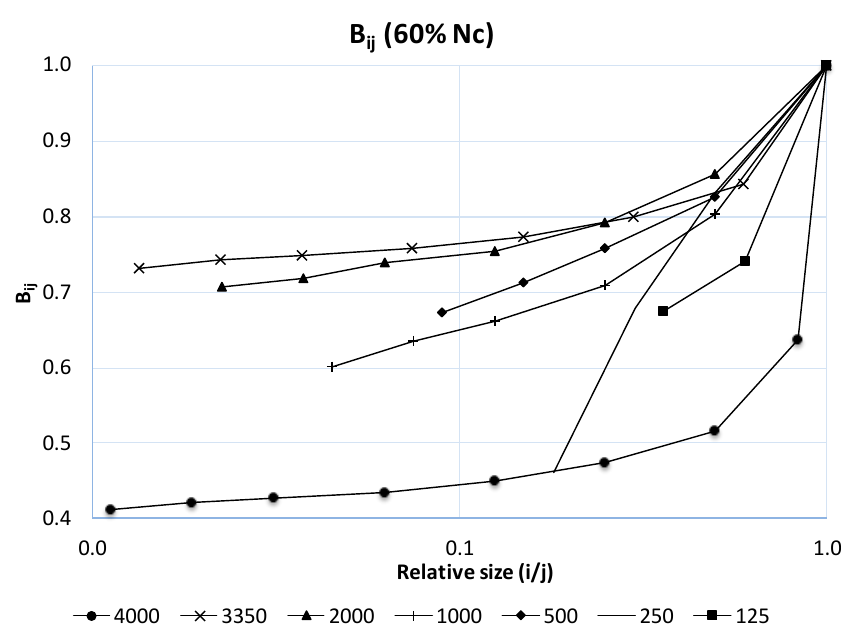
Figure 4. Behavior of the fracture function ( B ij ), with respect to particle size. 60% working speed Nc (Barruecopardo ore).